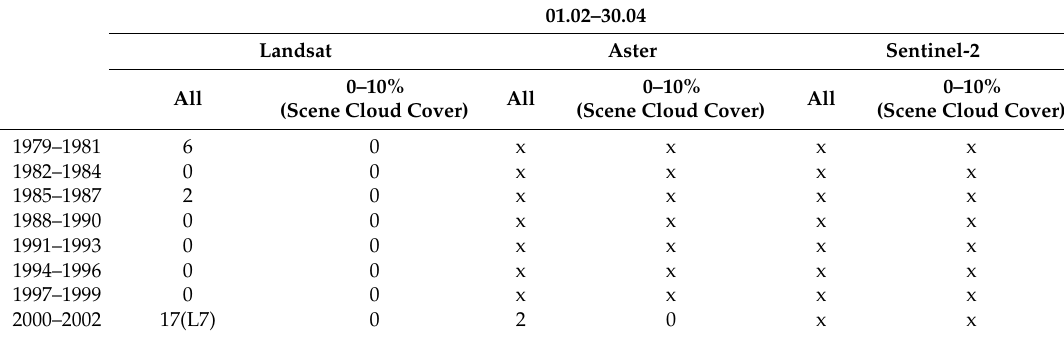
Table 1. The public archival satellite data available for ASPA-128, in the Australian summer months from 1978 to 2018, based on the USGS Earth Explorer: